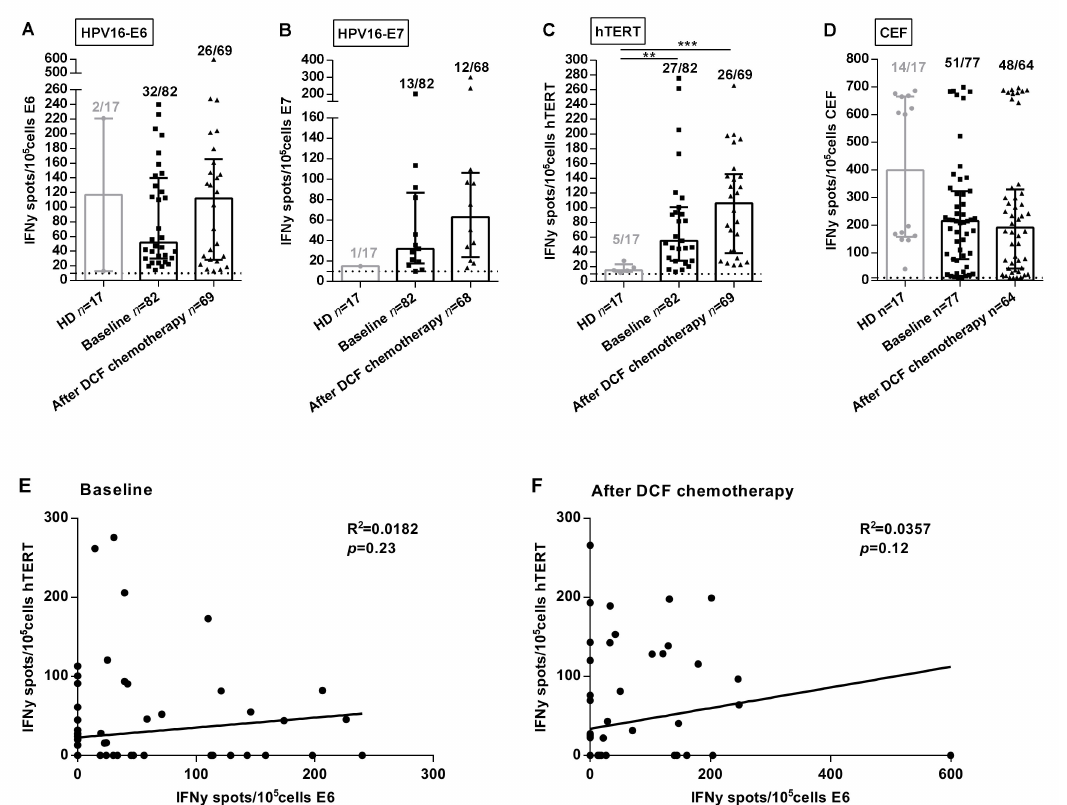
Figure 1. Frequencies and intensities of antigen-specific T-cell responses in SCCA patients. PBMC from 17 healthy donors and SCCA patients before ( n = 82) and after ( n = 69) DCF chemotherapy were analyzed for antigen-specific T-cell responses by IFN γ ELISpot assay. A-C Intensity of positive HPV16-E6 ( A ), HPV16-E7 ( B ) and hTERT ( C ) specific T-cell responses in healthy donors and SCCA patients before and after DCF treatment. ( D ) Intensity of positive antiviral T-cell responses. Healthy donors population is represented by light gray points and SCCA patients by black points. Mann Whitney U test, where ** p < 0.01, *** p < 0.001. Median with interquartile range was indicated on graphs. Only the positive intensities of specific immune responses were indicated. ( E , F ) Correlation between HPV16-E6- and hTERT-specific immune responses before ( E ) and after DCF chemotherapy ( F ) in SCCA